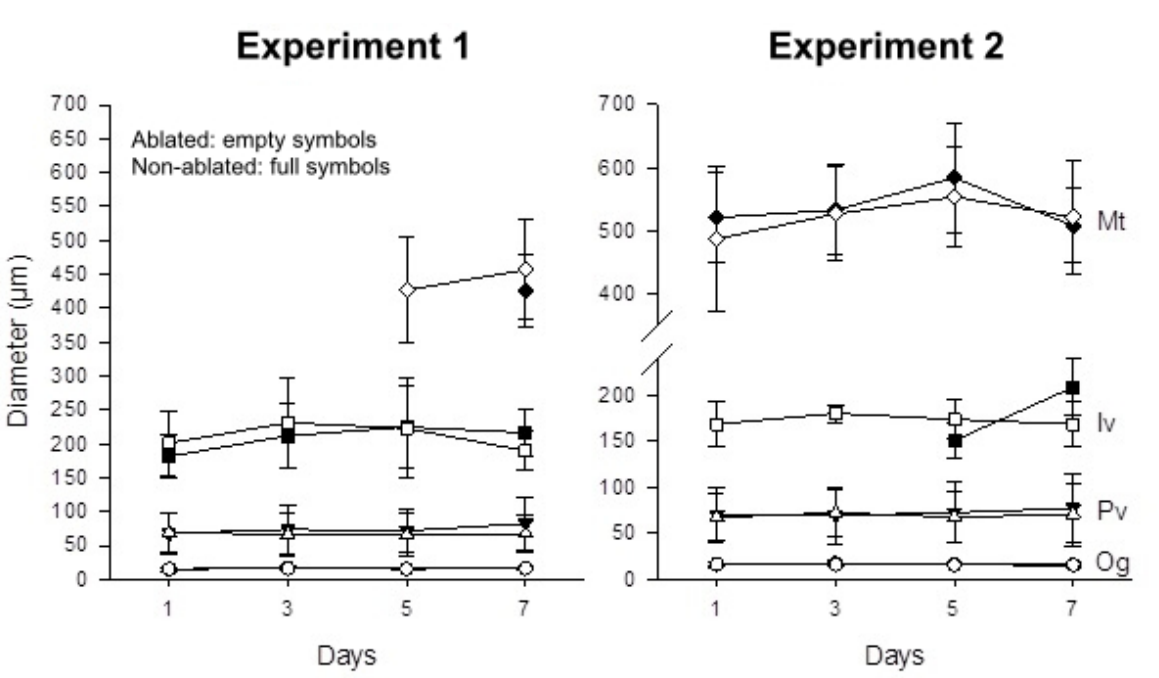
Figure 4. Mean diameter of oocyte per developmental stage in the ovaries of Macrobrachium acanthurus females in two experiments after 1, 3, 5, or 7 days. Oocyte in vitellogenesis - Iv; mature oocyte - Mt; oogonia - Og; previtellogenic oocyte - Pv. There was no significant difference ( p > 0.05) between ablated and non-ablated